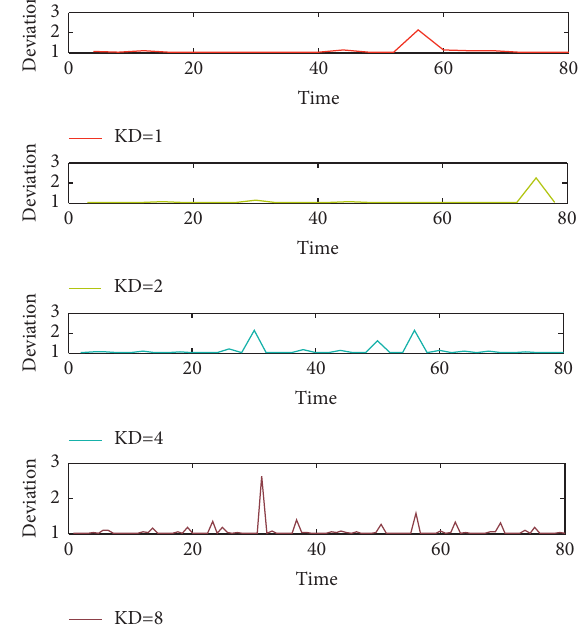
Figure 7: The influence of KD on the transition process (KP � 2, KI � 0.5).